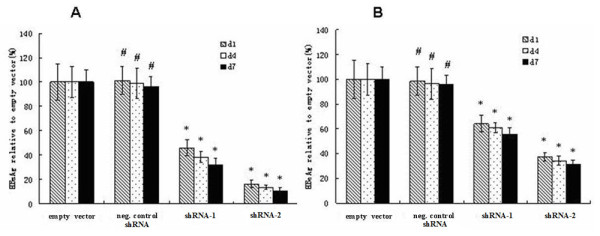
Serum HBV antigens levels in HBV shRNA-treated mice. (A) HBsAg levels in NOD SCID mouse sera were significantly reduced after treatment with the shRNA expression lentiviral vectors pWPT-HBV-shRNA-1 and shRNA-2. (B) The levels of HBeAg were significantly reduced by treatment with HBV shRNAs in mice. Inhibition of HBV antigens were specific and lasted at least 7 days (error bars indicate standard errors). The values showed the average of three experiments (means standard deviation). The mean value of empty control was defined as 100%. *P < 0.05 vs. the empty vector group. # P > 0.05 vs. the empty vector group.